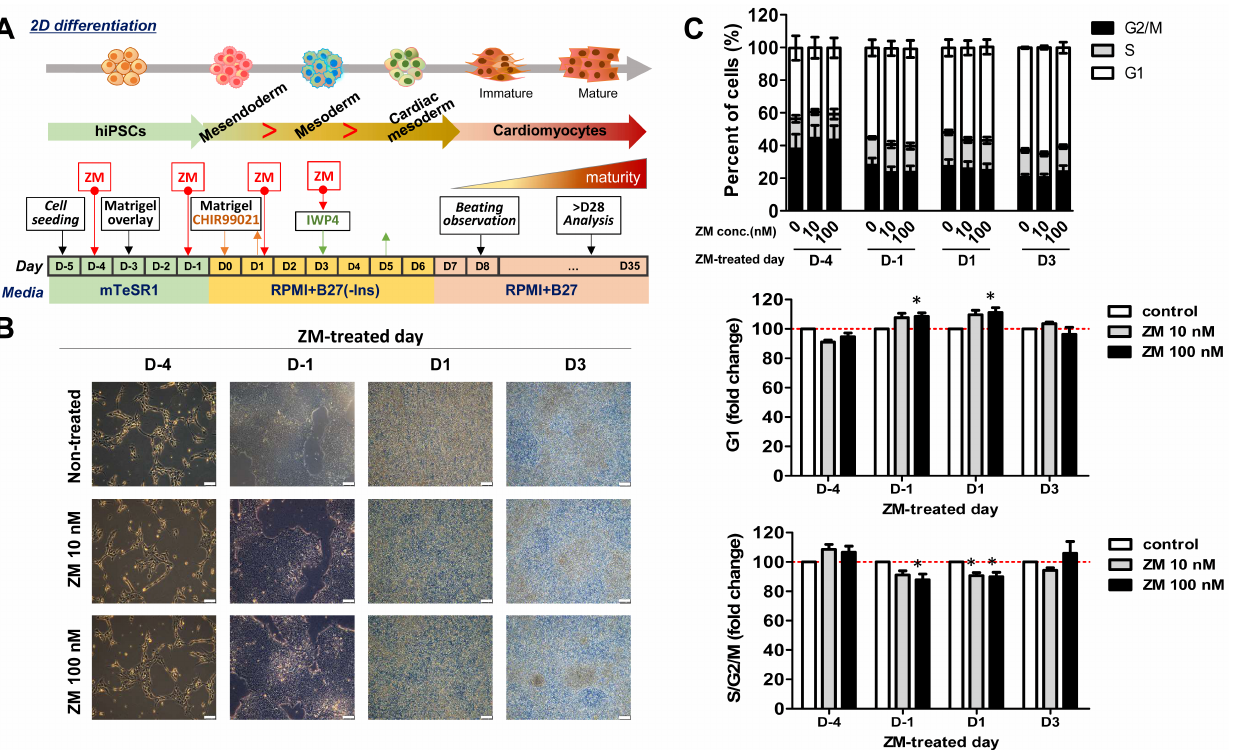
Figure 2. Effects of ZM447439 on the cell cycles of differentiated cardiac cells from hiPSCs: ( A ) Protocol of cardiomyocyte differentiation treated with ZM447439. ( B ) Differentiation of ZM-treated cardiomyocytes. Scale bar, 100 µ m. ( C ) Cell cycle profile of cardiac-differentiated cells with 0, 10, and 100 nM ZM treatment ( n = 3–4, top). G1 (middle) and S/G2/M proportions (down) of ZM-treated samples at D-4, D-1, D1, and D3, respectively. Data are presented as the mean ± SEM. * p < 0.05, by Dunnett’s